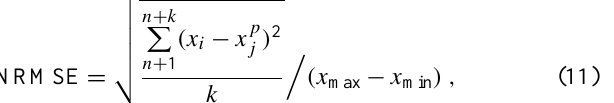
0 . 0299 for 2 hour predictions and 0 . 0415 for 3 hour predic- Renewable Energy Laboratory, USA, for the 234 locations 30-day intervals and plotted for a 3-year period. Figure 11b tions. Thisshowsthatthepredictionaccuracyobservedinthe typical forecasts shown in Fig. 8 are more or less maintained depicted in Fig. 10. shows NRMSE for 1 h prediction for each location averaged across all locations and various time periods consistently. over a 3-year time period (time-averaged NRMSE) where the horizontal dotted line shows the mean 0 . 0136 of these values over the locations. Similar estimates of location and time-averaged errors for 2 h predictions are given in Fig. 11c and d and for 3 h predictions in panels e and f. The mean of the time-averaged NRMSE over the locations, indicated in each figure by a dotted line, is 0 . 0299 for 2 h predictions and 0 . 0415 for 3 h predictions. This shows that the prediction ac- curacy observed in the typical forecasts shown in Fig. 8 is more or less maintained across all locations and various time periods